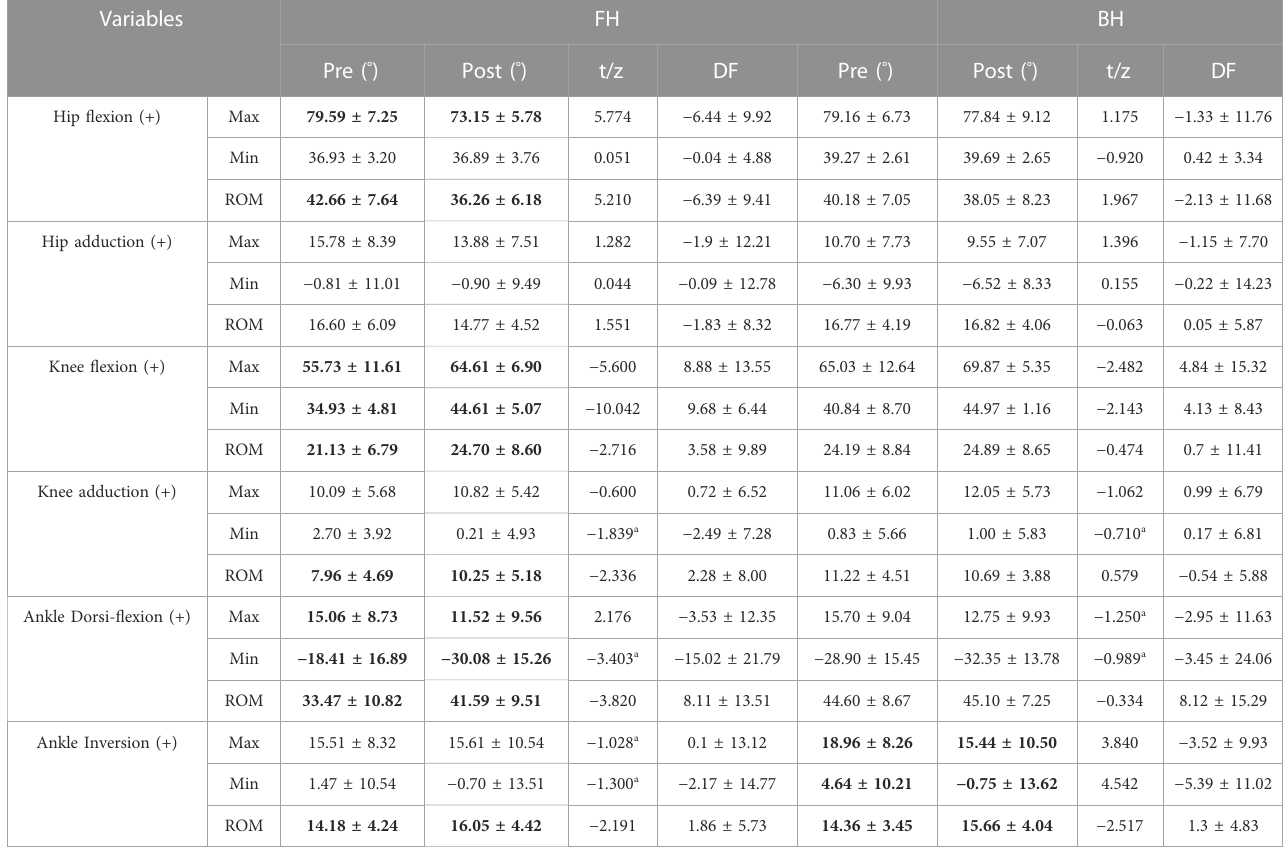
TABLE 1 Comparison of pre-fatigue and post-fatigue means standard deviations for joint angles and ROM values during the strike phase of the FH and BH (unit: degrees).